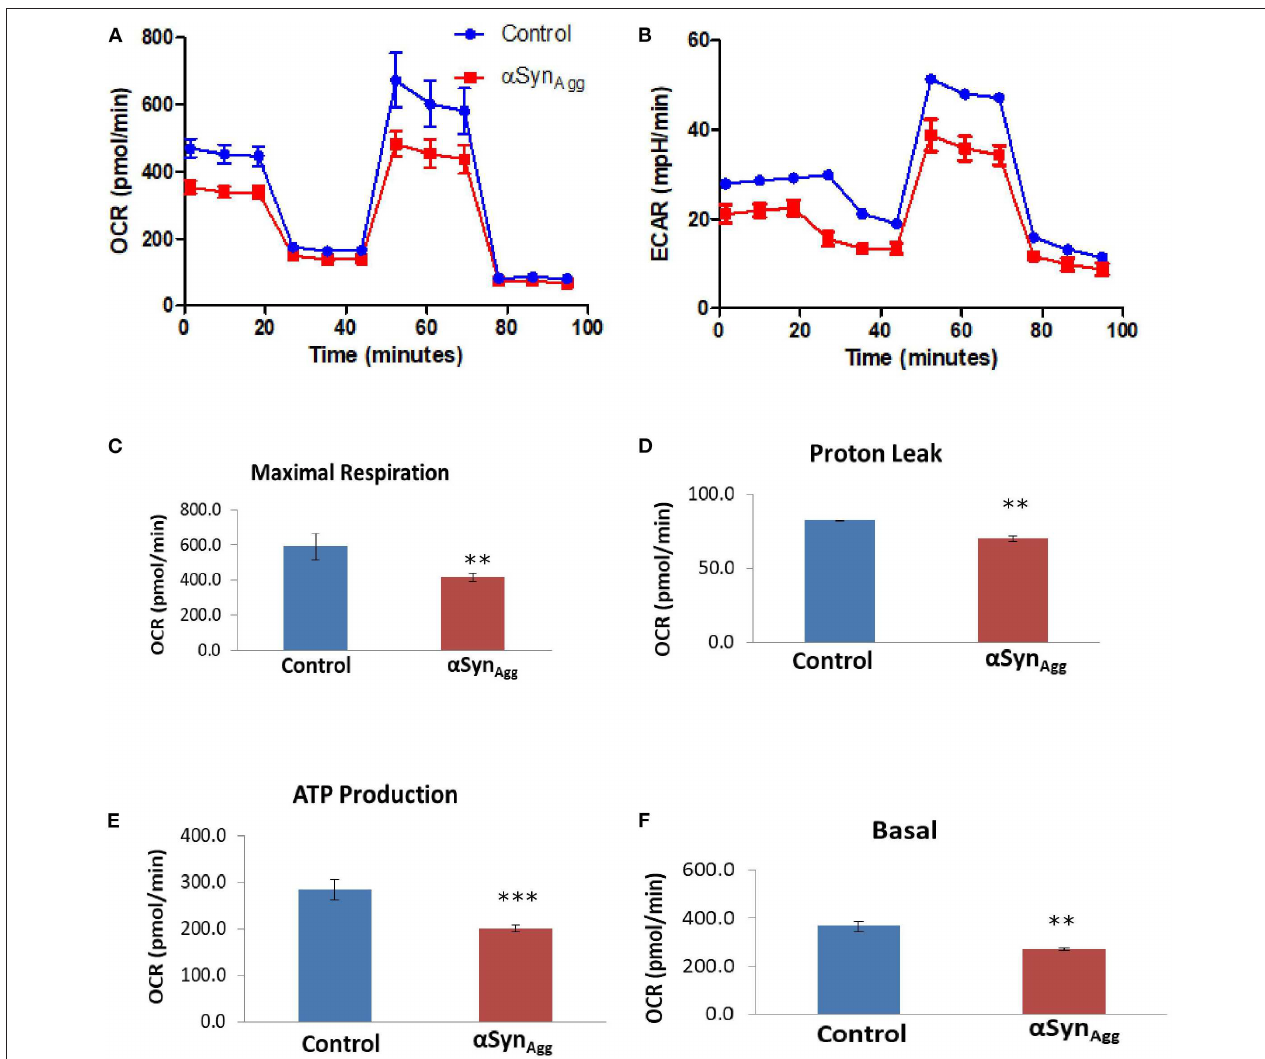
FIGURE 6 | α Syn induced mitochondrial dysfunction in microglial cells. Primary microglial cells were treated with 1 µ M α Syn for 24h and Seahorse Mitostress test was performed. (A) OCR and (B) ECR of primary microglial cells treated with α Syn. (C) Maximal respiration, (D) Proton leak, (E) ATP production, and (F) Basal respiration of primary microglial cells treated with α Syn. Data analyzed using student’s t -test with n = 4 for each group. ** p < 0.01, *** <